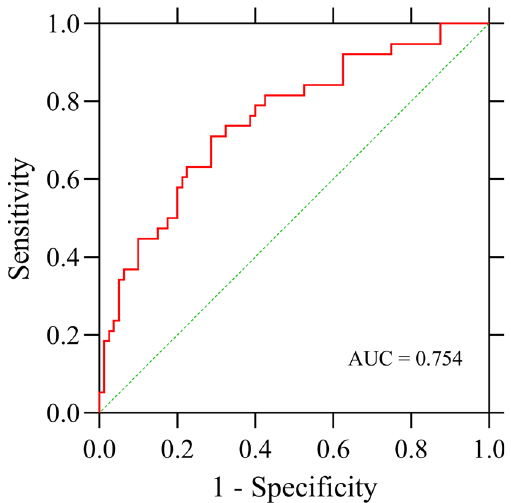
Fig. 4 ROC curve for predicting EGFR mutation status in male NSCLC patients using pSUV max and serum tumor markers CYFAR21-1 and SCC-Ag. When pSUV max , serum CYFAR21-1 and SCC-Ag concentrations were combined to predict EGFR mutation status, the AUC was